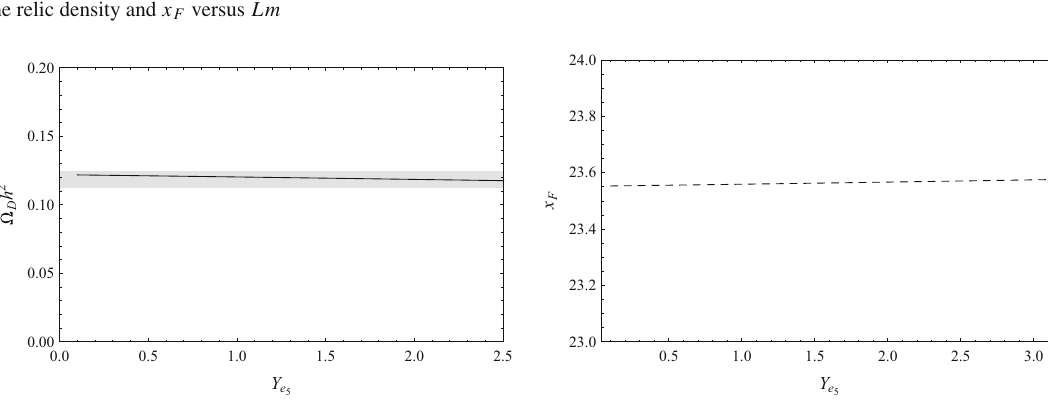
Fig. 5 The relic density and x F versus Lm